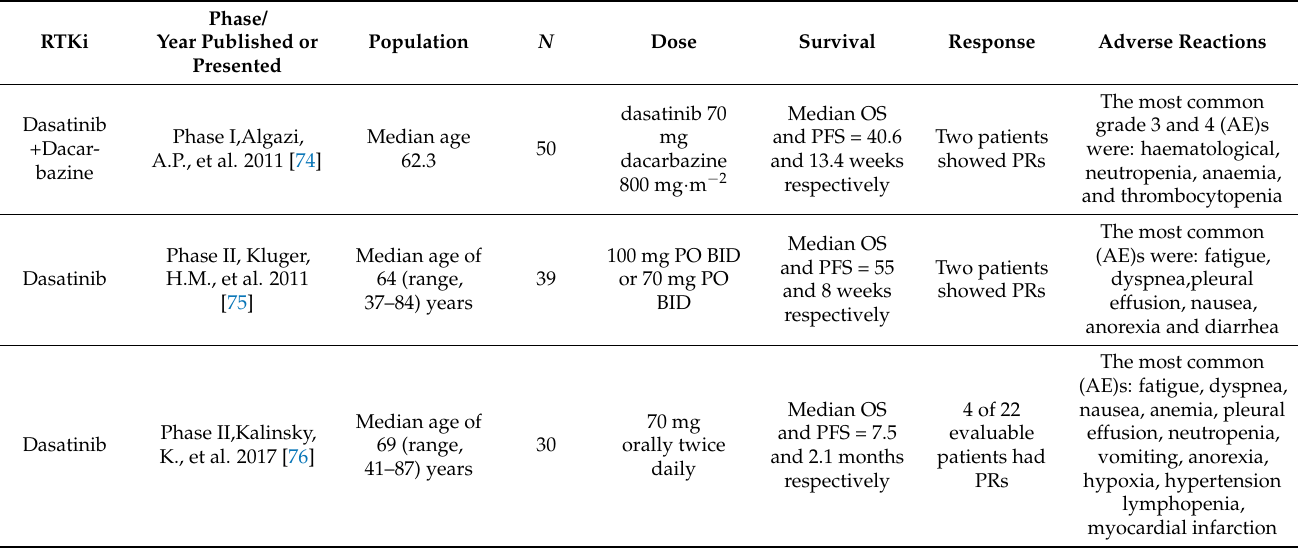
Table 4. Dasatinib monotherapy or in combination in melanoma clinical